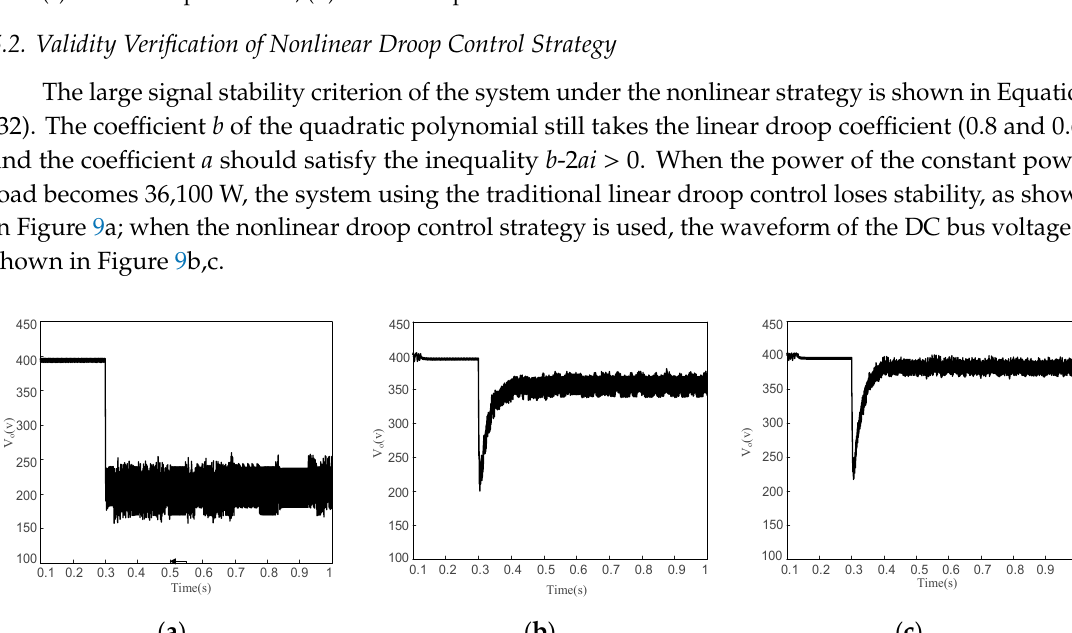
( c ) No.3 set of parameters; ( d ) No.4 set of parameters.